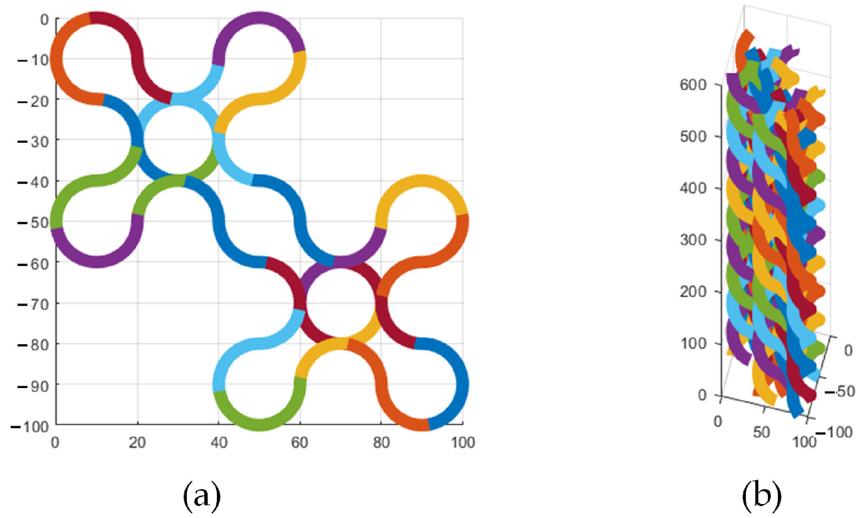
Figure 7. MATLAB simulation of a 3D braided double T-profile: ( a ) 2D tracks; ( b ) 3D simulated image. The default view shows the 2D tracks of all bobbins. However, using the internal rotation function of three-dimensional MATLAB plots, the simulated image can be rotated like a CAD model. The resulting image corresponds to the 3D braid with the programmed bobbin positions and bobbin tracks in the real machine